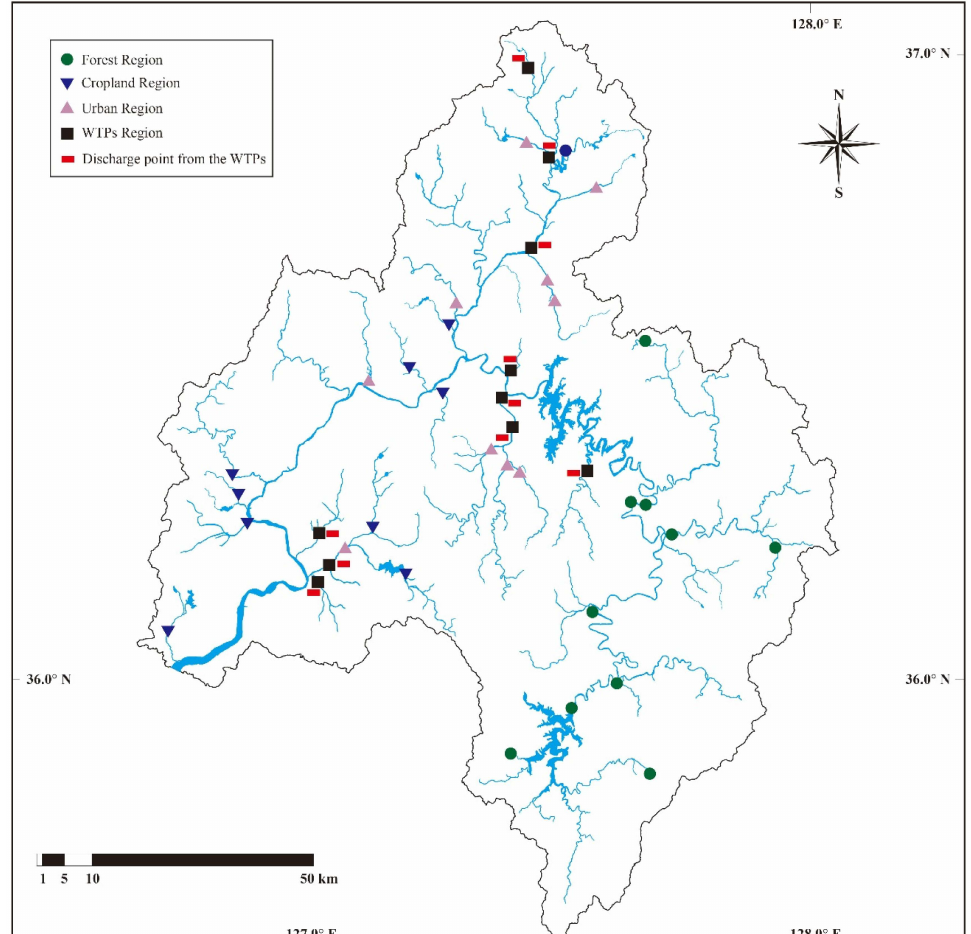
Figure 1. Catchment-scale map showing the location of the four different land types, among the 40 sampling sites of the Geum-River